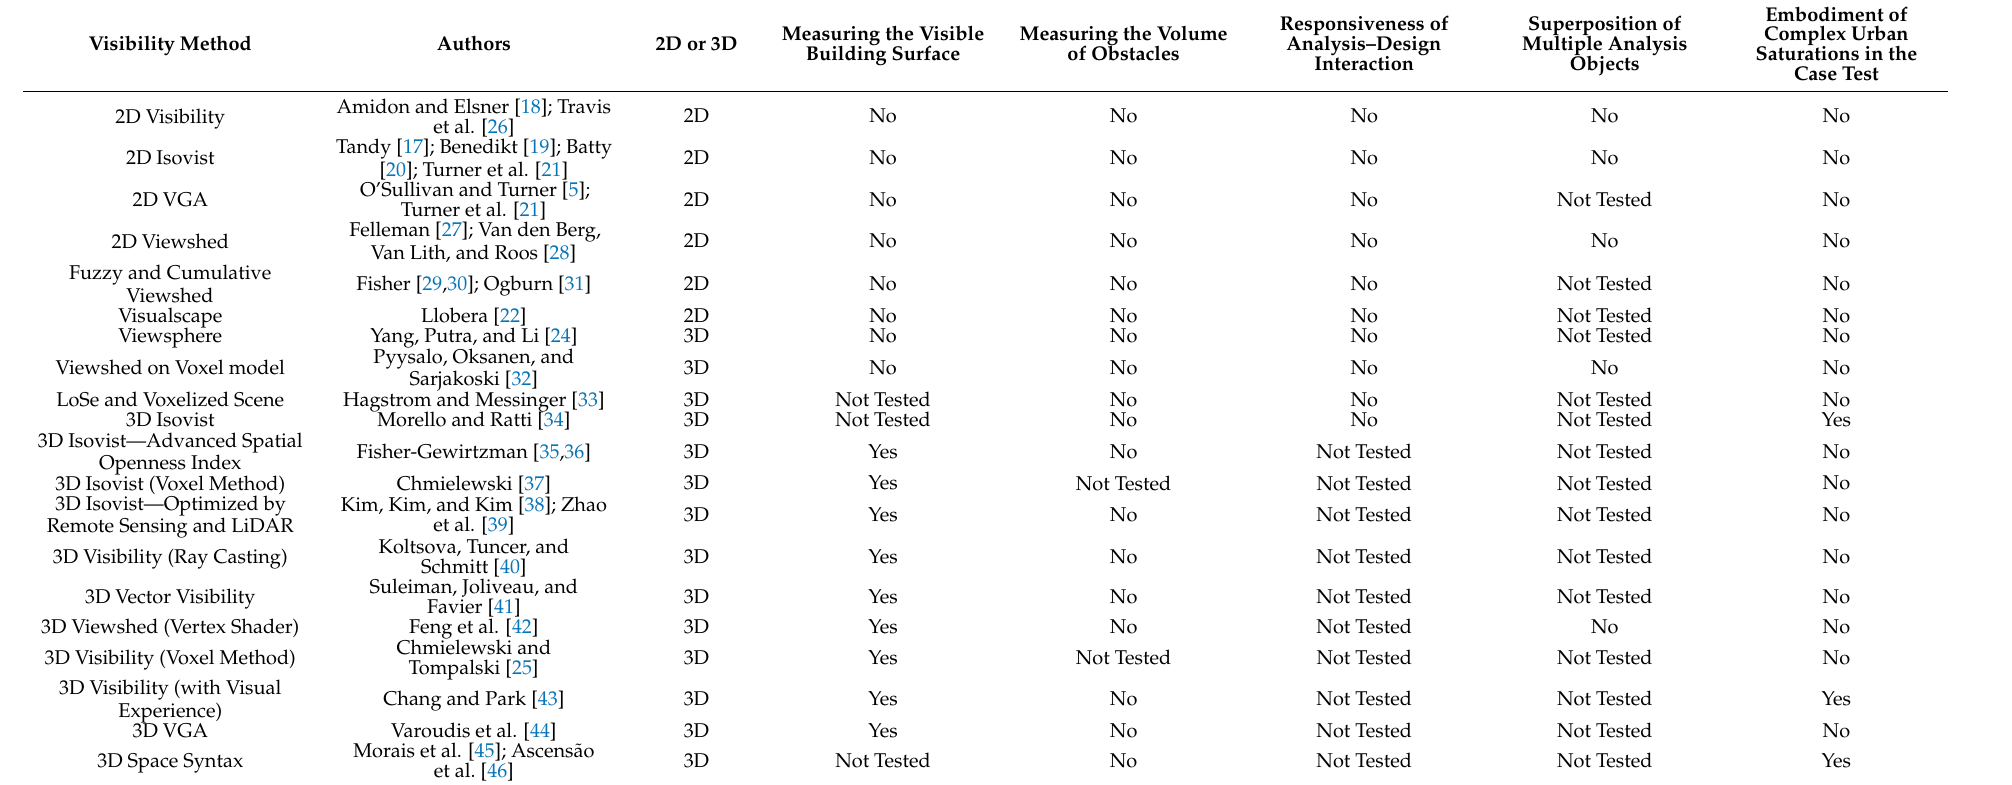
Table 1. Summarizing the main analytical methods that have evolved [25] and comparing and discussing the value of their evaluation and impact on the urban model in the design